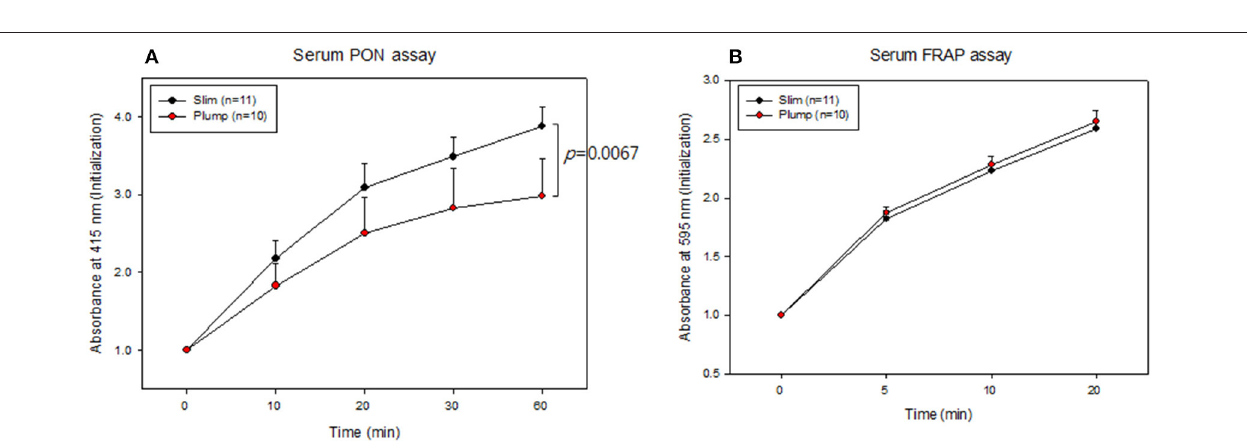
FIGURE 4 | Serum antioxidant activity. Paraoxonase activity (A) and ferric ion reduction ability (B) .